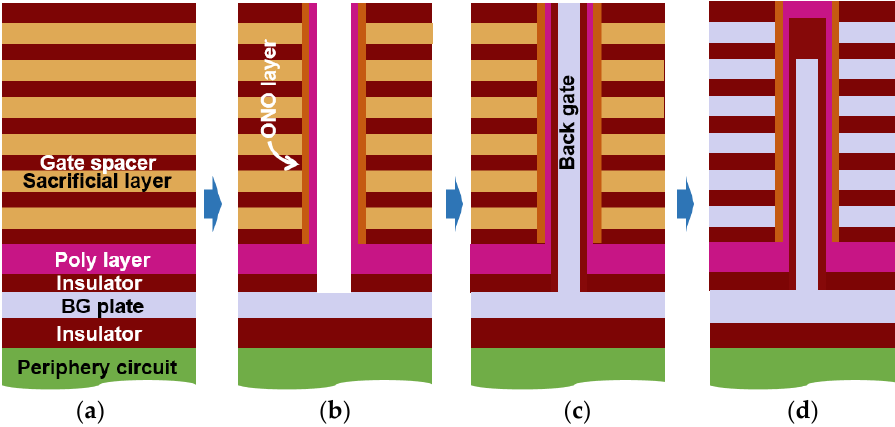
Figure 1. GAAB fabrication flow. ( a ) BG plate formation before substrate deposition; ( b ) channel-hole etching and ONO, poly-channel deposition; ( d ) BG dielectric and BG formation ’ and ( d ) BG recess and channel capping.